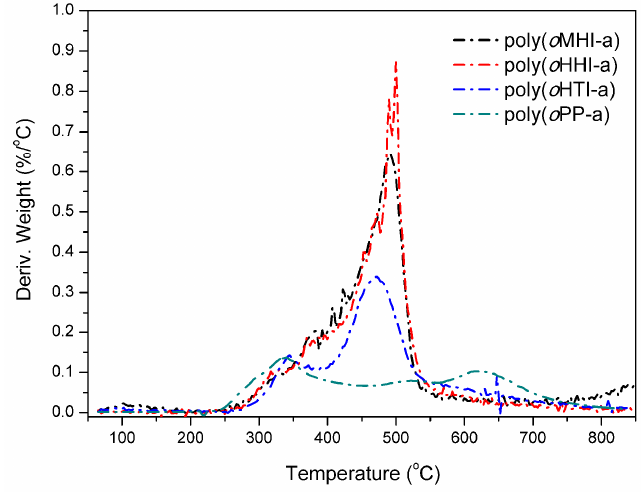
Figure 10. Derivative weigh loss of poly( o MHI-a), poly( o HHI-ac), poly( o HTI-a), and poly( o PP-a). Table 2. Thermal properties of ortho -imide functional polybenzoxazines. Polybenzoxazine Based